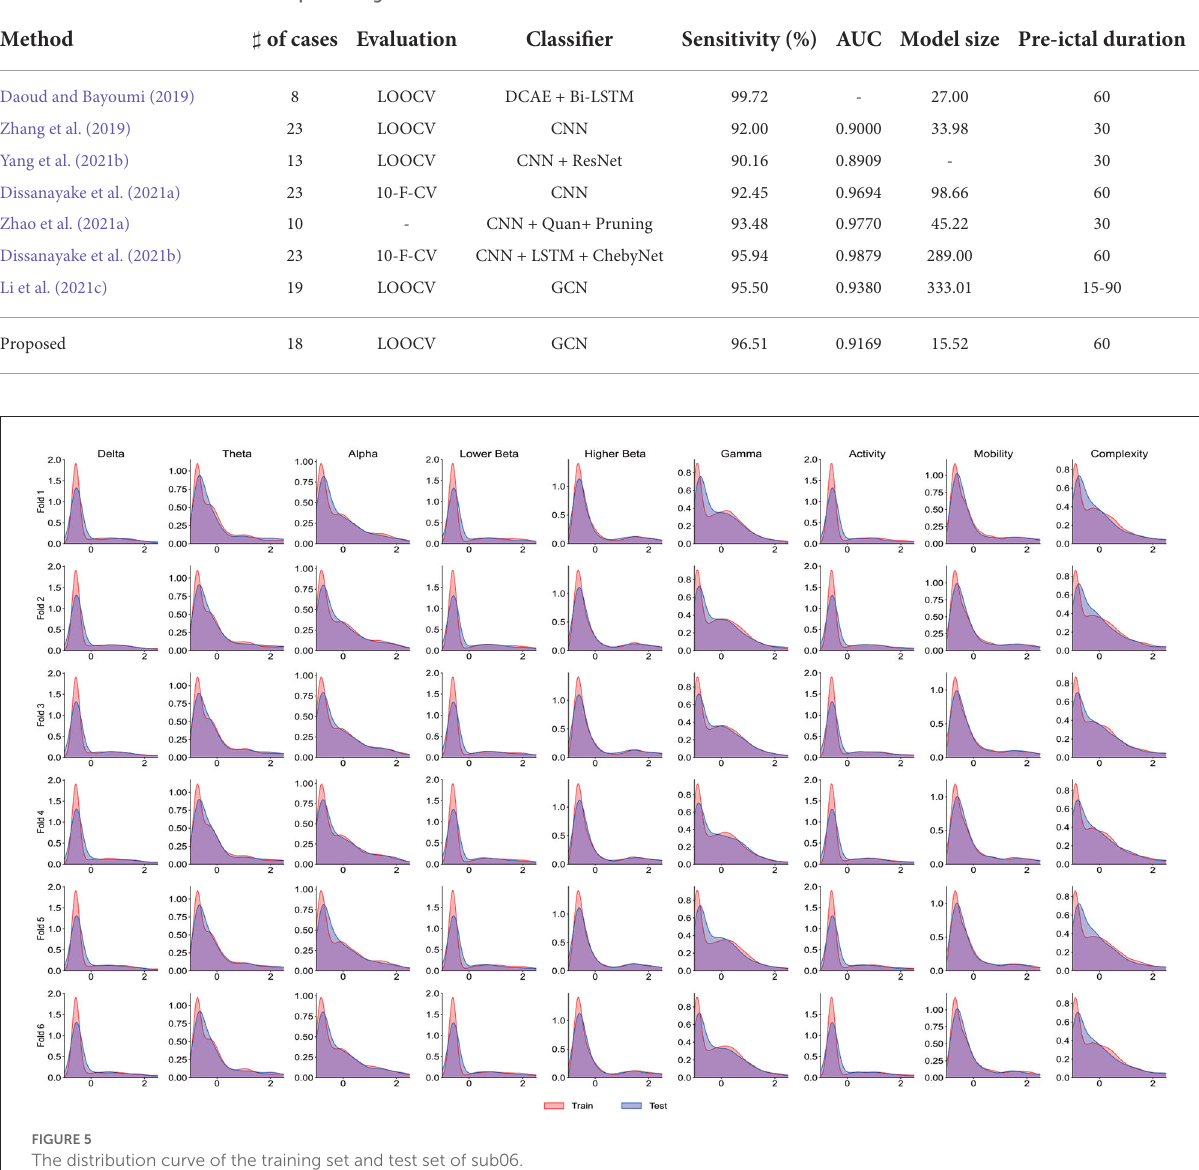
TABLE 3 Result of recent studies on predicting seizures on the CHB-MIT dataset.